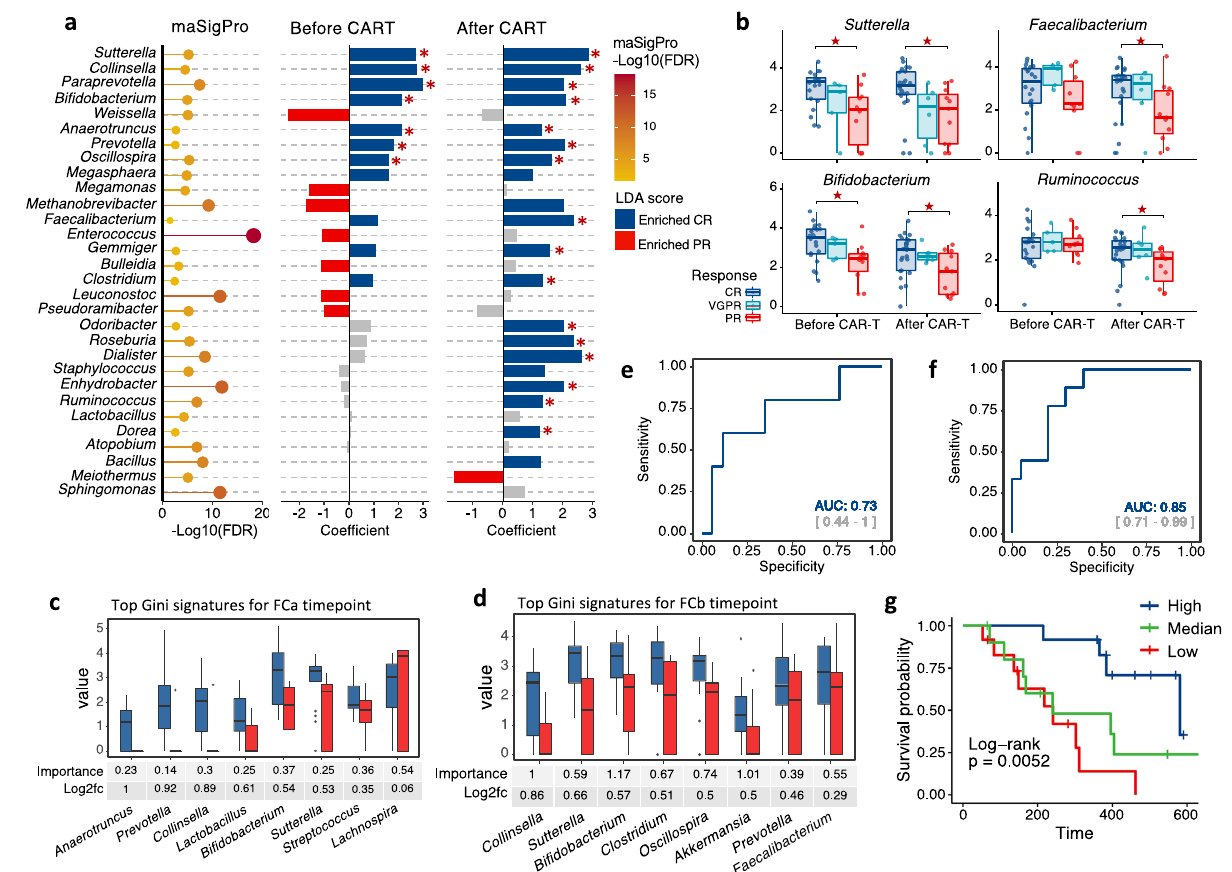
Fig. 4 | Determination of correlated genera with clinical response to CAR-T therapy in MM patients. a Differentially abundant genera between CR and PR group. Bubble plot in the left represents p values by maSigPro. Bar plots in the middle and right show signi fi cances and coef fi cients by generalized linear-mixed models (GLMMs) before and after CAR-T infusion ( n =35). Blue bars indicate sig- ni fi cant enrichment in CR group while red bars indicate signi fi cant enrichment in PR group (FDR<0.05). Red stars marked genera that was identi fi ed to be